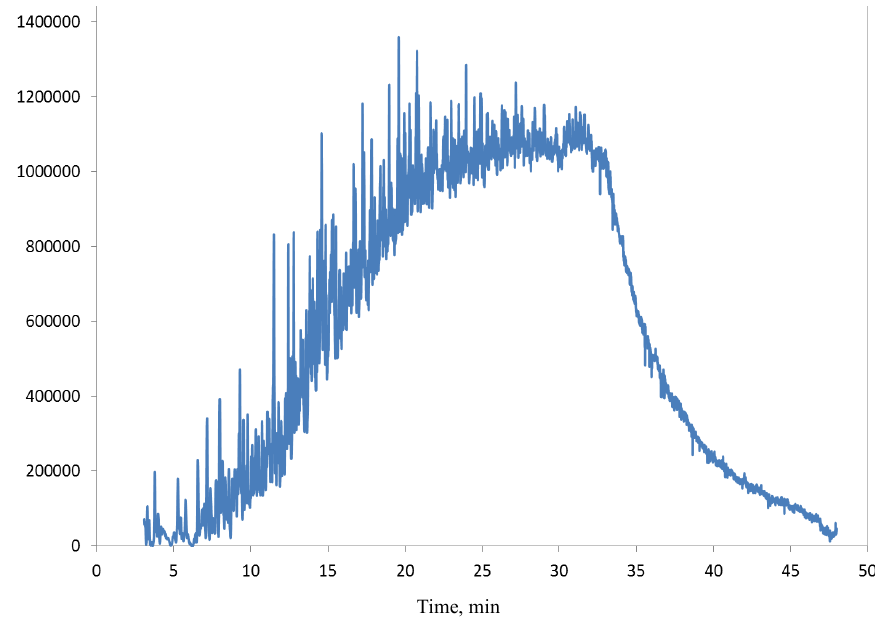
Fig. 1. Chromatogram obtained after deduction of blank sample chromatogram from oil chromatogram. The oil distillation curve obtained is shown in Fig. 2. According to the method, mass fraction of distilled oil to 530–550 °С is accepted as 100